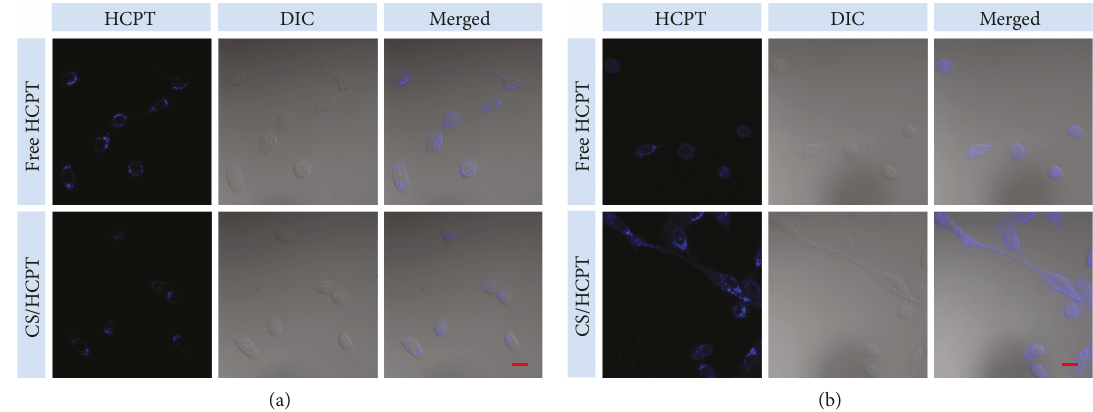
Figure 2: Representative CLSM microimages of 4T1 cells incubated with free HCPT and CS/HCPT for 2 (a) and 6h (b). For each panel, the microimages from left to right showed HCPT fl uorescence in cells (blue), di ff erential interference contrast (DIC) image, and the overlay of two images. The scale bar represented 20 μ m.